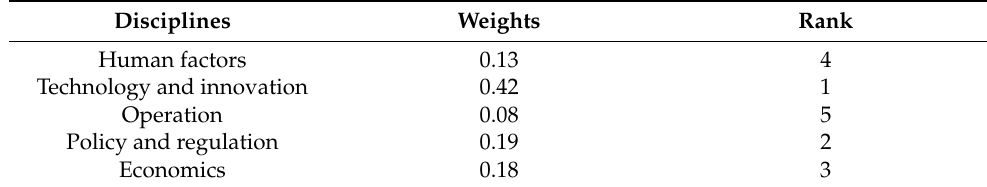
Table 2. The discipline weights.